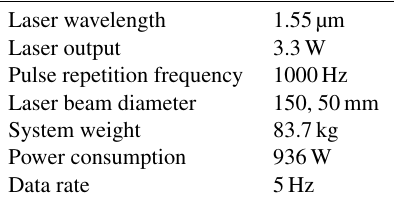
Figure 2. Coherent Doppler lidar used in this work. Table 1. Coherent Doppler lidar